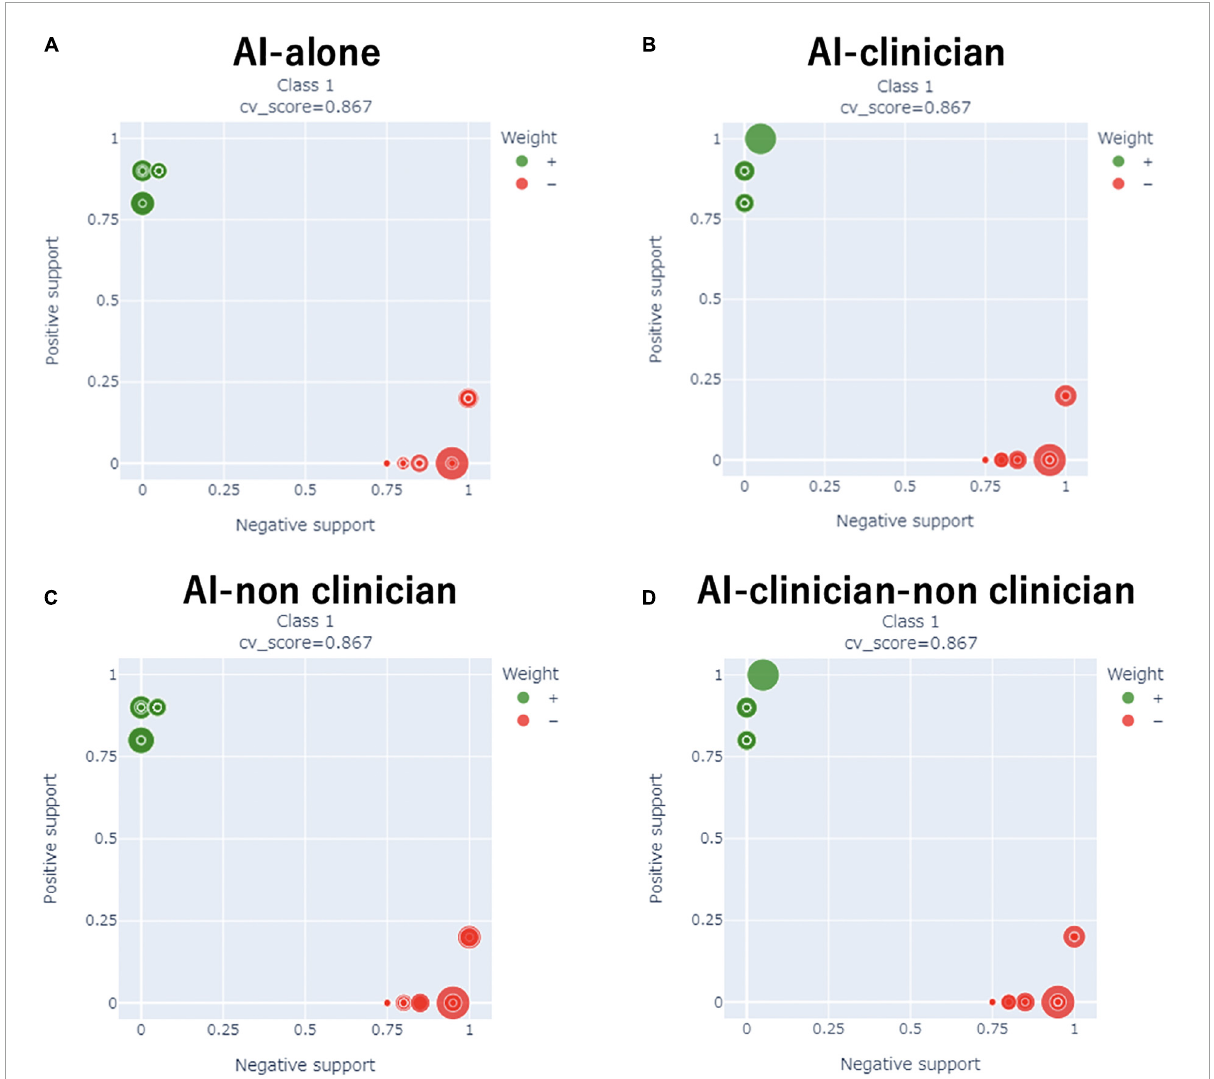
FIGURE2 Comparisons of the performance of the AI-alone, AI-clinician, AI-non-clinician, and AI-clinician-non-clinician models to predict oxygen needs based on characteristics and laboratory biomarkers of patients with COVID-19. (A) AI-alone, (B) AI-clinician, (C) AI-non-clinician, and (D) AI-clinician-non-clinician. The green dots show the model’s performance in predicting oxygen needs in patients with COVID-19. The red dots show the model’s performance in predicting when patients with COVID-19 do not need oxygen